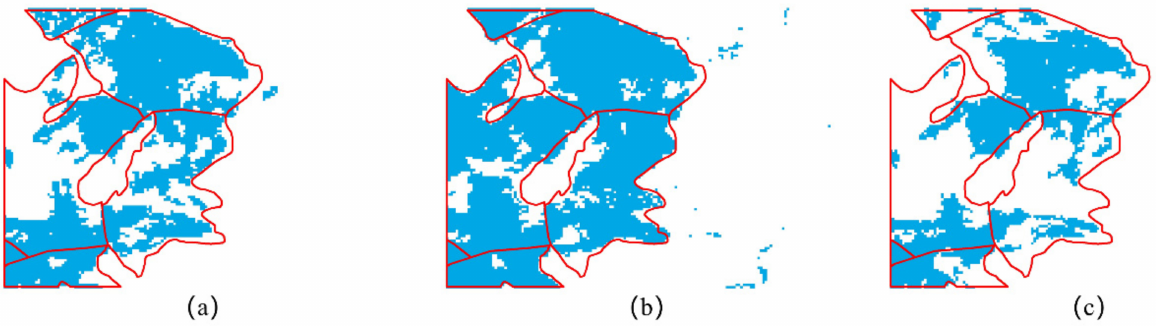
Figure 6. Cloud score threshold setting experiment: the blue area is the extracted glacier, the red line is the glacier boundary of the dataset, and the cloud scores of the three images were set to 40 ( a ), 60 ( b ) and 80 ( c